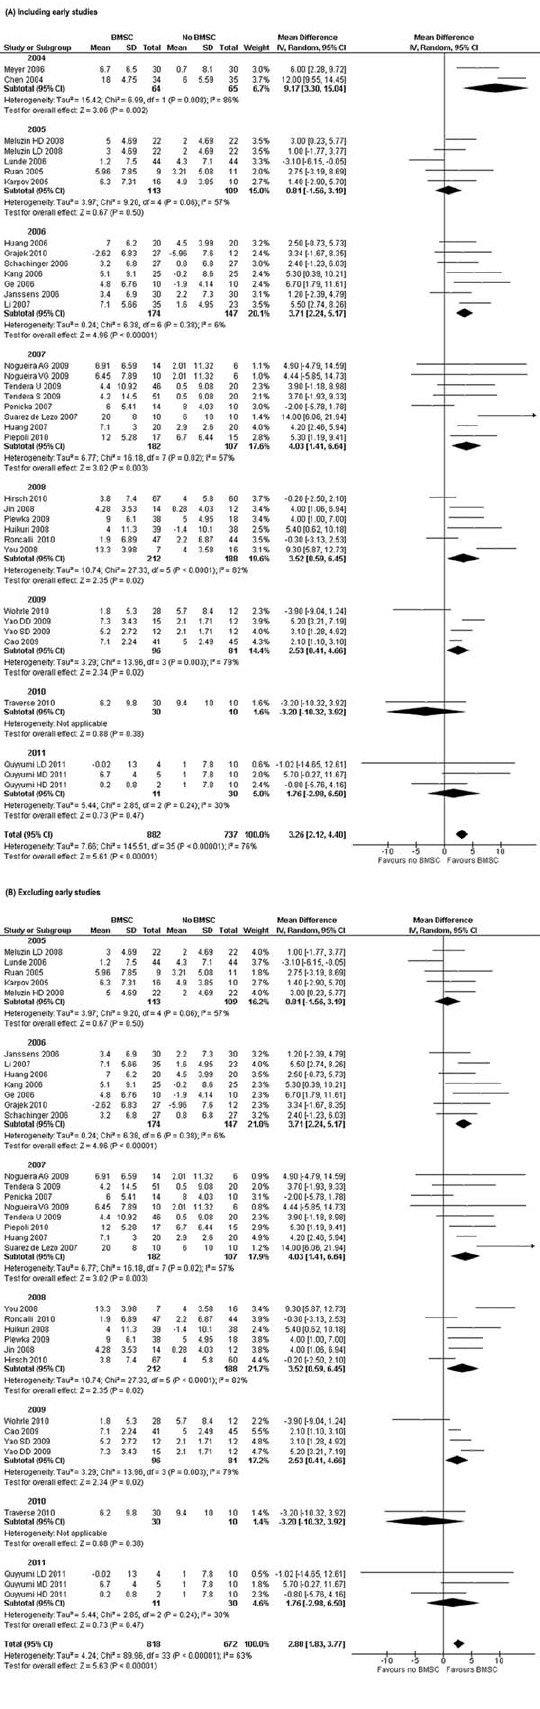
Figure 3. Forest plot of Weighted Mean Difference [WMD, with 95% CI (confidence interval)] in left ventricular ejection fraction (LVEF) in short-term follow-up sub-grouped by the year of the first results’ disclosure. (A) Including early studies reporting data in 2004 (3.26%, 95% CI 2.12 to 4.40, p , 0.00001).and (B) excluding studies with early reporting in 2004 (2.80%, 95% CI 1.83 to 3.77, p , 0.00001). BMSC treatment significantly improved LVEF in both meta-analyses. WMD had overlapping CI and were not significantly